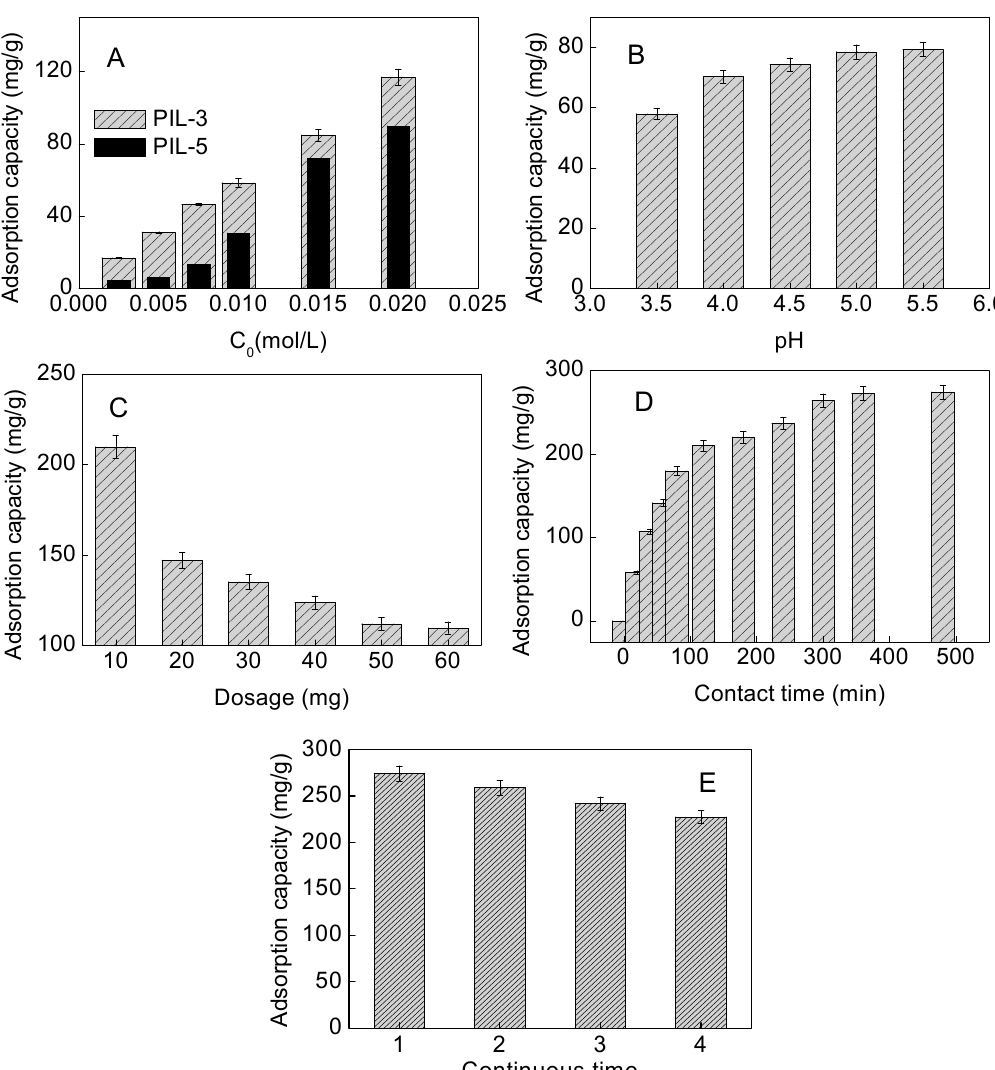
Figure 4. The effect of C 0 on the adsorption performance of PIL-3 and PIL-5 for Zn 2+ ( A ), the effect of pH ( B ), adsorbent dosage ( C ), contact time ( D ) and continuous times ( E ) on the adsorption performance of PIL-3 for Zn 2+ .